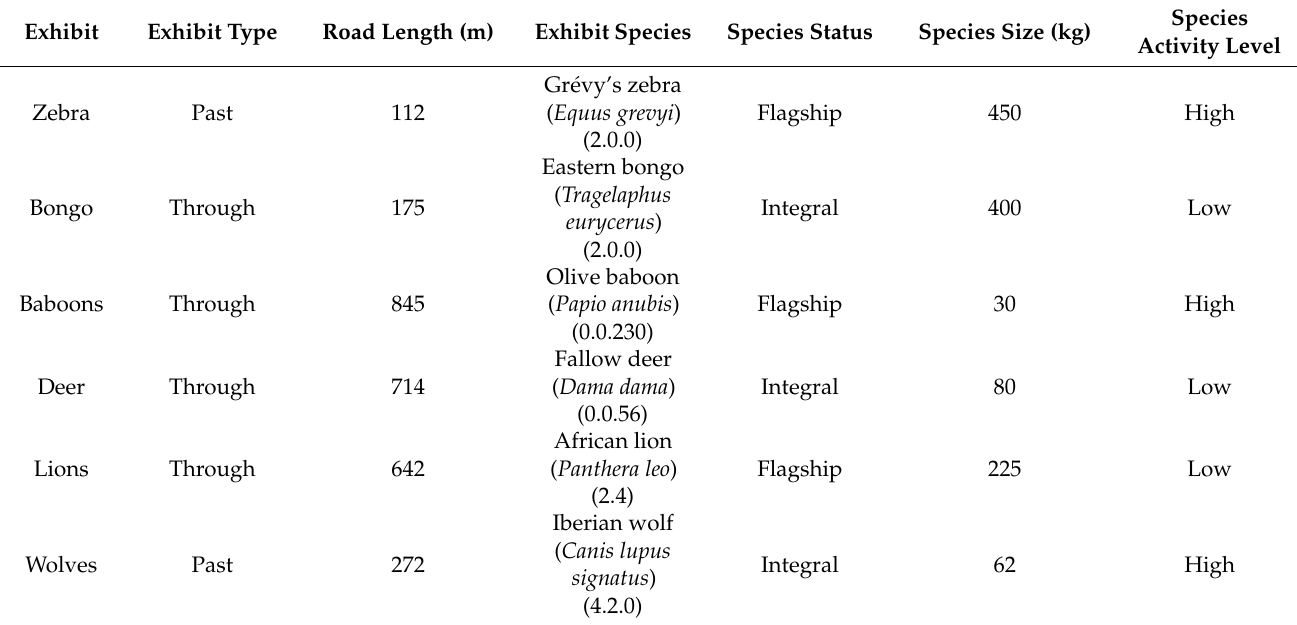
Table 2. Species traits and exhibit features recorded at the start of the study, as defined in Table